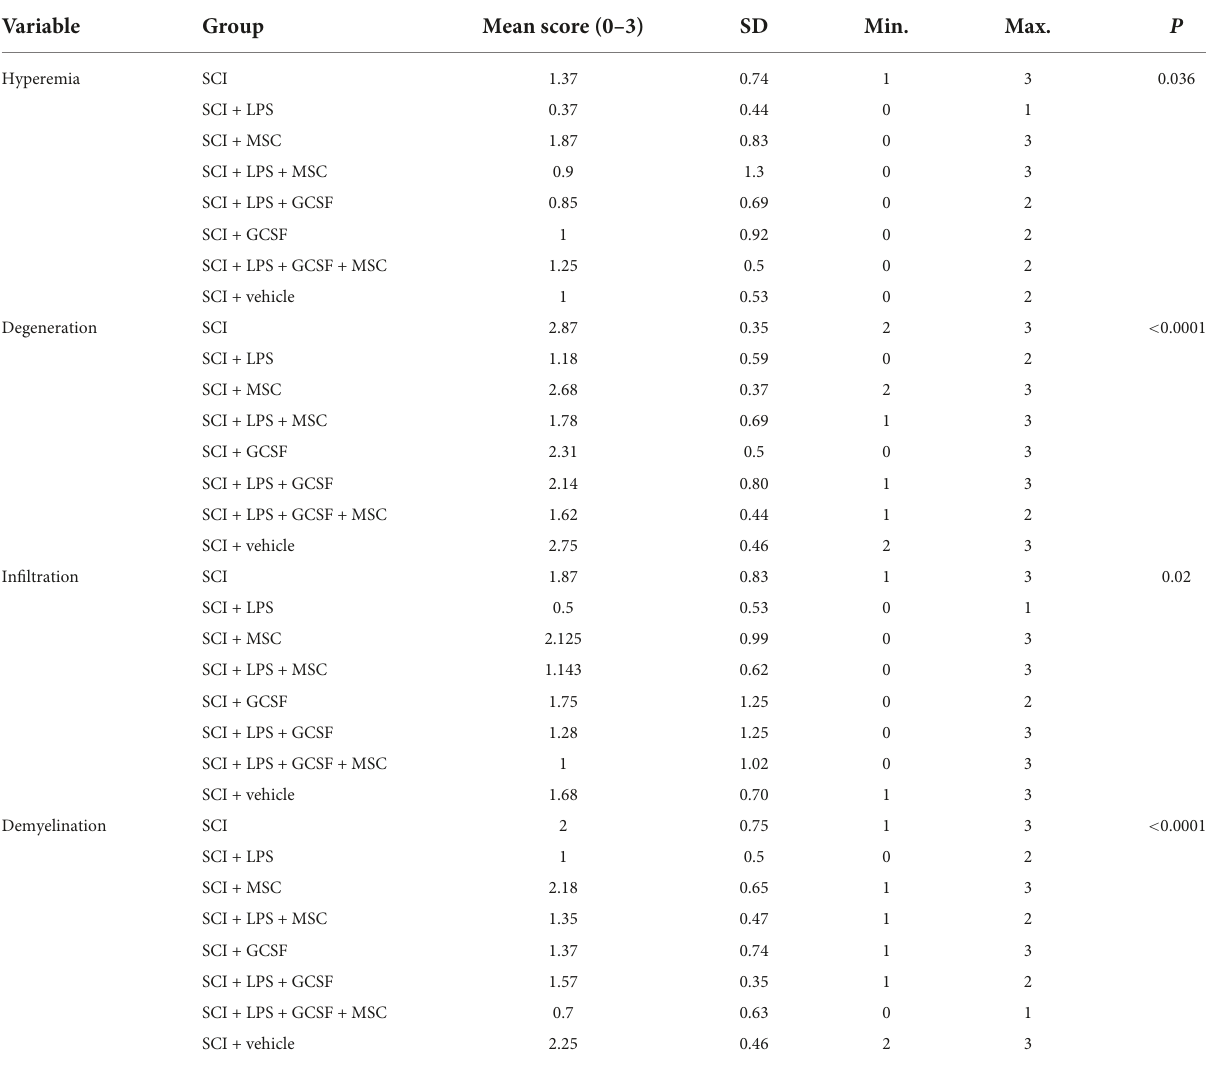
TABLE 2 Histological analysis scores according to the hyperemia, degeneration infiltration, and demyelination between SCI and treatment groups at 1 week post-SCI. Variable